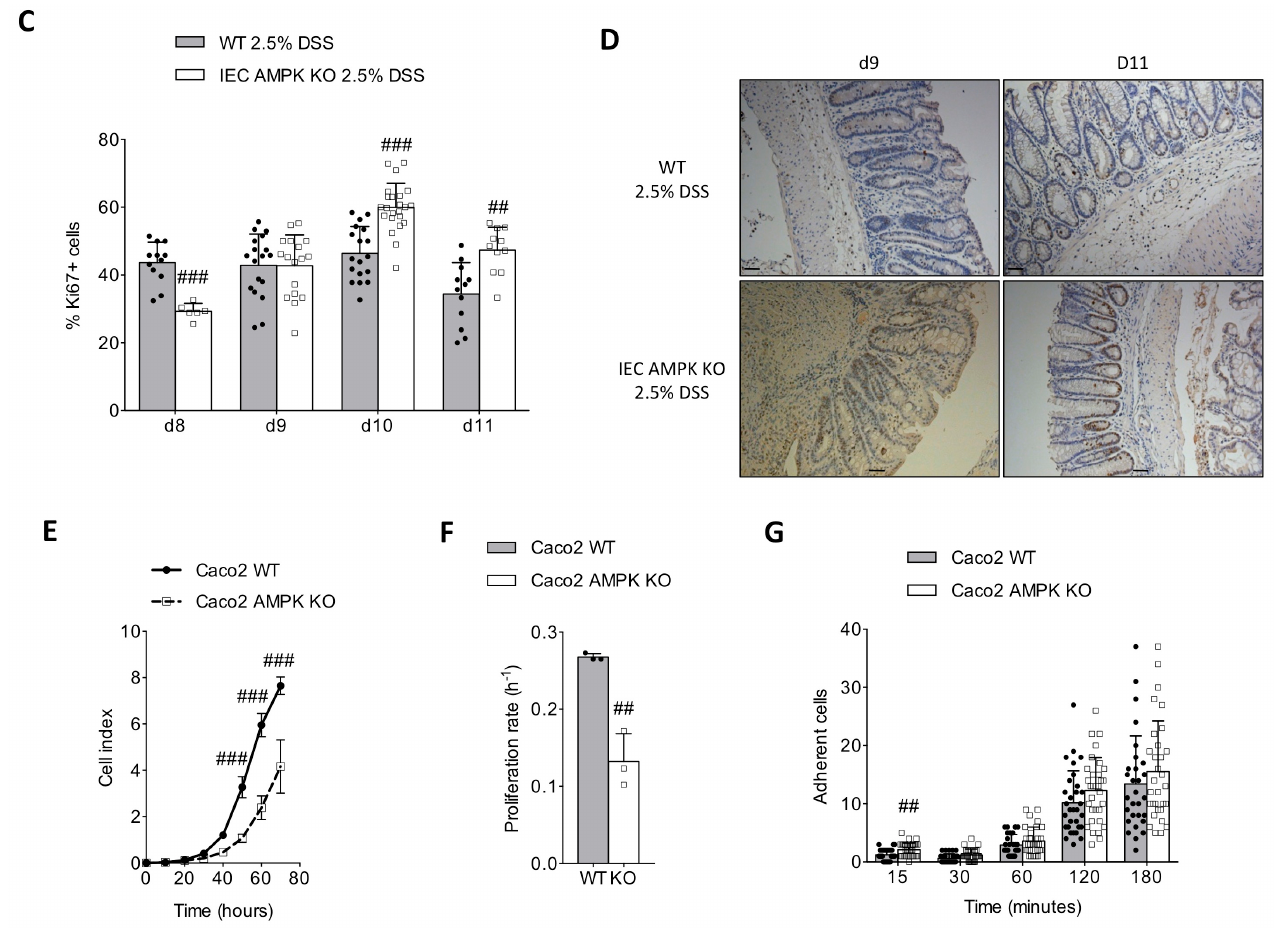
Figure 3. Altered cell proliferation but not adherence in AMPK-deficient Caco2 cells. ( A ) Repre- sentative H&E-stained colon from IEC AMPK KO and WT mice at 5 days after γ irradiation with 10 Gy. Pictures are representative of 6–10 mice/group. White arrow indicated dead crypts and *